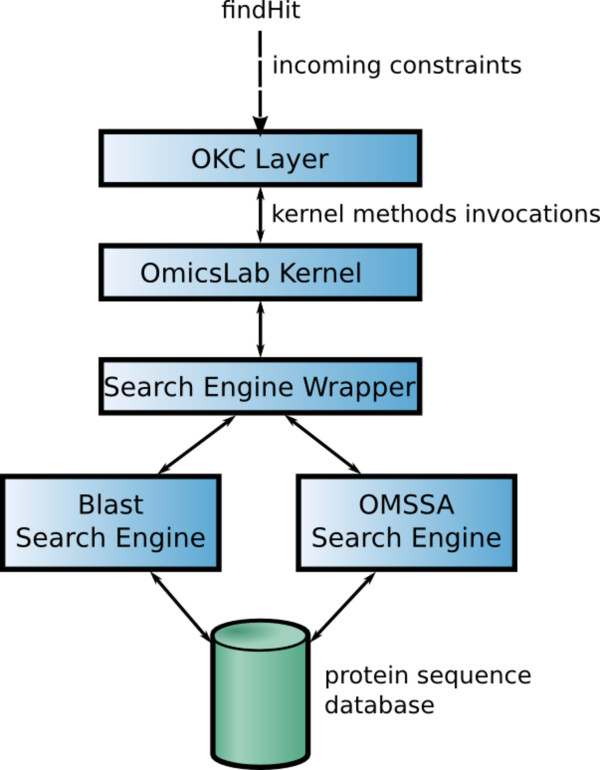
Schematic view of the omicslab OKC architecture.